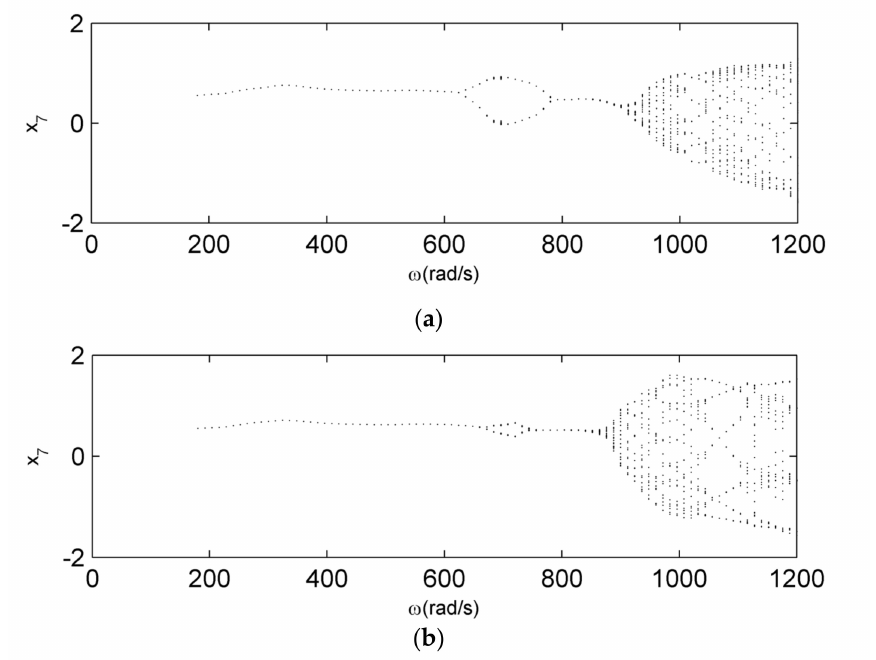
Figure 20. Bifurcation diagrams for coupled fault system. ( a ) b = 0.00015. ( b ) b = 0.00012.